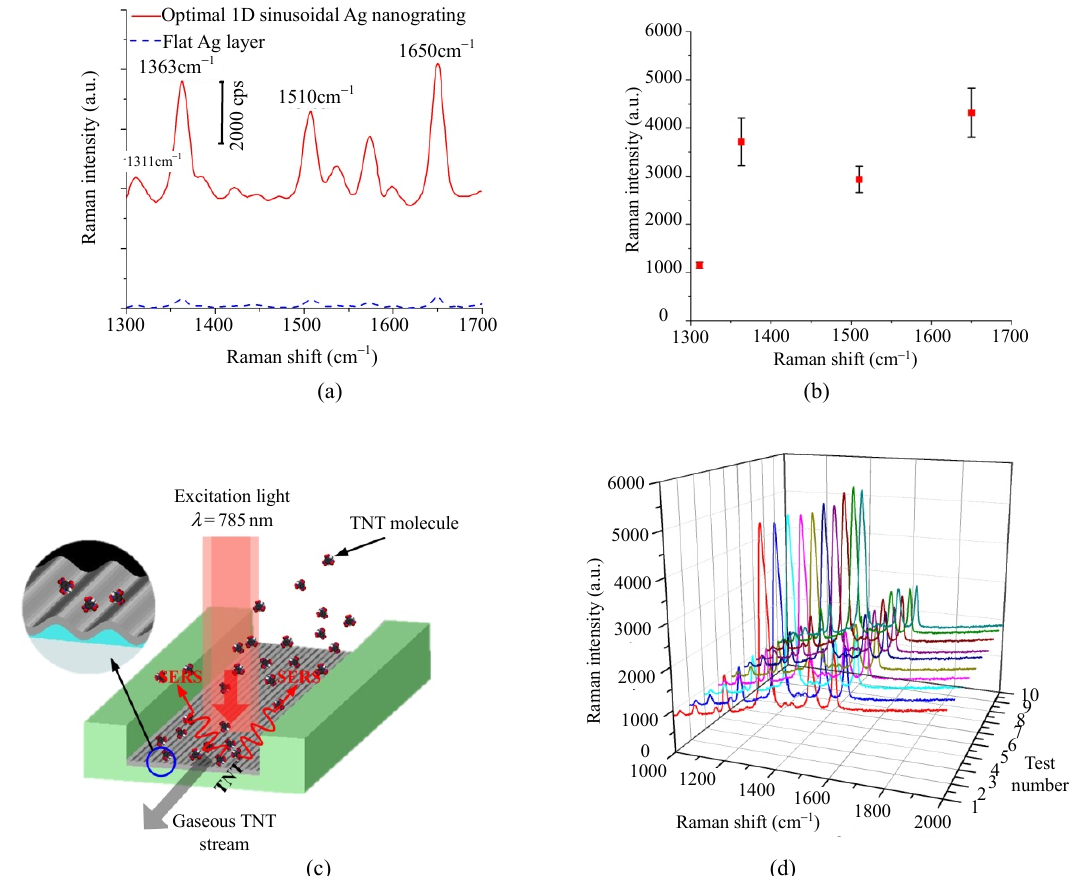
Fig. 9 SERS performance experiments of the 1D sinusoidal Ag nanograting: (a) Rh6G Raman spectra from the flat Ag layer and 1D sinusoidal nanograting, (b) error bars of the relative Raman intensities from the 1D sinusoidal nanograting, (c) schematic illustration of the label-free SERS detection of trace TNT, and (d) ten times detection of trace TNT with 5 minutes